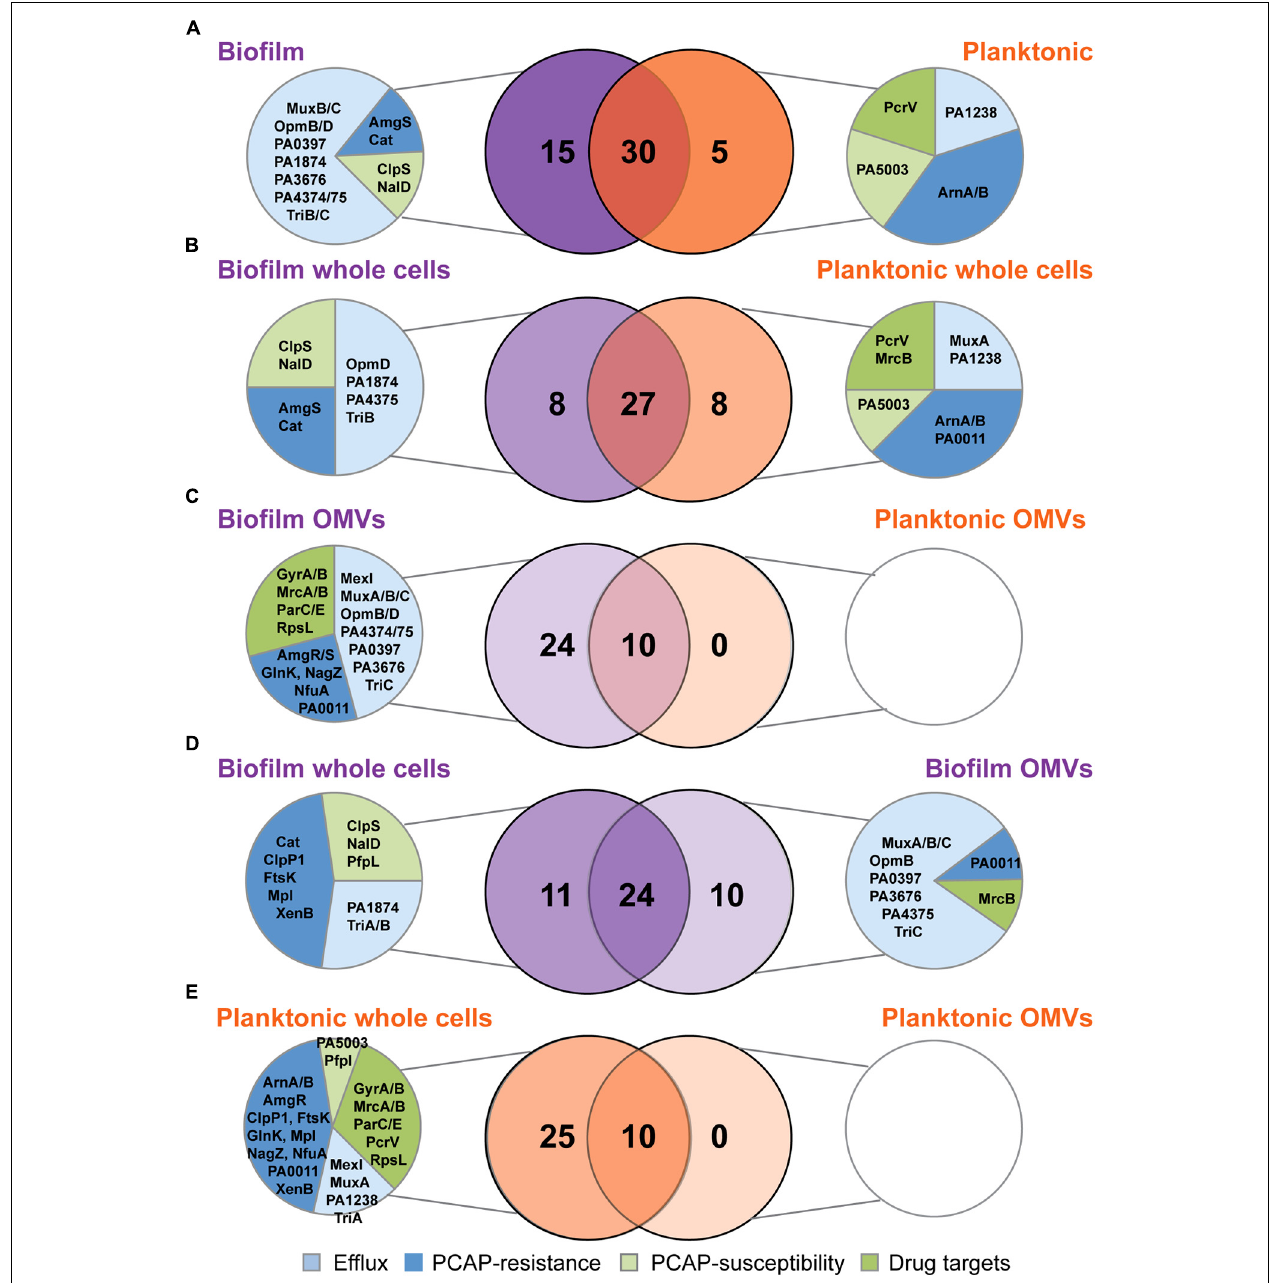
FIGURE 4 | Individual subproteomes have unique antibiotic and resistance proteins with both redundant and distinct functions. (A–E) Venn diagrams showing shared and exclusive proteins among growth modes and sample types. Biofilm sample groups are shown in purple and planktonic sample groups are shown in orange. Unique proteins for each comparison (if